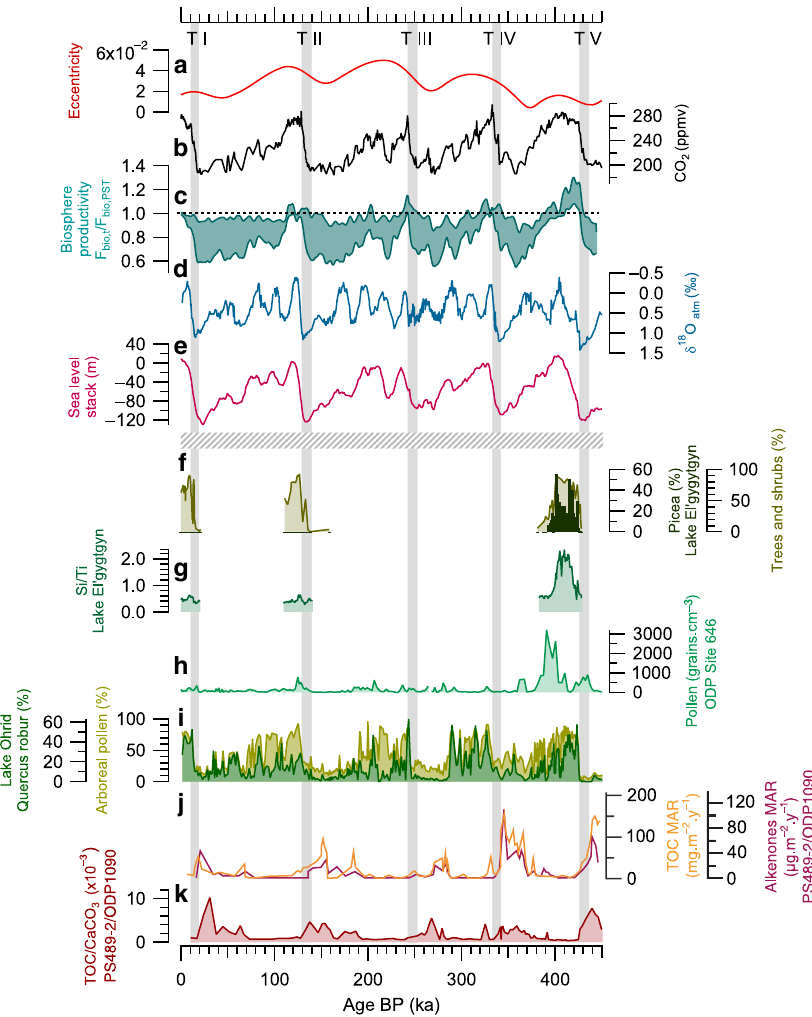
Fig. 3 Global and regional productivity records since 450 ka. a Eccentricity 71 . b CO 2 record (ppmv) 69 . c Reconstructed envelop for the ratio between global biosphere productivity and pre-industrial biosphere productivity as inferred from Δ 17 O of O 2 at age t (interpolation to 200 years and 101 binomial smoothing with Igor software). d δ 18 O atm record from the EDC ice core 18,72 – 76 . e LR04 Sea level stack (m compared to present) on AICC2012 timescale 77 . f Trees, shrubs and Picea pollen (%) 16 ; g Si/Ti ratio 16 ; a proxy of biogenic silica normalised to detrital, re fl ecting the changes in diatom productivity in the lake. h Pollen abundance (grains.cm − 3 ) of ODP Site 646 26 . i Arboreal and Quercus robur pollen records (%) from Lake Ohrid, Balkan Peninsula 46,47 . j Alkenone mass accumulation rate (MAR) ( µ g ⋅ m − 2 ⋅ year − 1 ) and TOC MAR (mg ⋅ m − 2 ⋅ year − 1 ) records at Site PS2489-2/ODP1090 3 . k TOC/CaCO 3 ratio at Site PS2489-2/ODP1090, Atlantic Southern Ocean 14 . The horizontal dotted line separates the ice core records presented on the AICC2012 timescale 24,70 (above the line) and the terrestrial and oceanic records presented on the age model of each core (under the line). The grey shadow bars represent the period of rapid increase in atmospheric CO 2